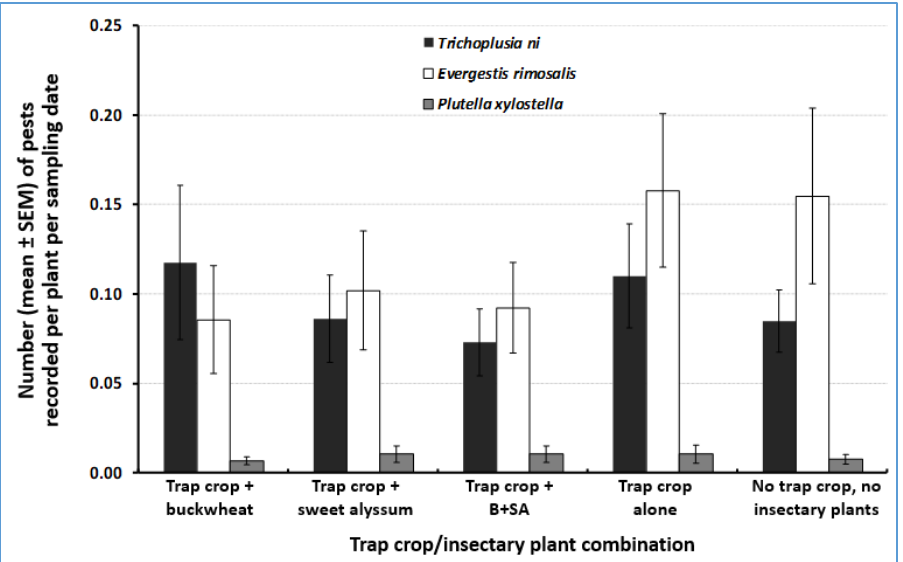
Figure 6. Pest cash crop abundance on a per-plant basis. B + SA = buckwheat + sweet alyssum. There were no significant differences in their abundance on cabbage plants in response to insectary plant treatment according to ANOVAS and Fisher-protected LSD tests ( p < 0.05).